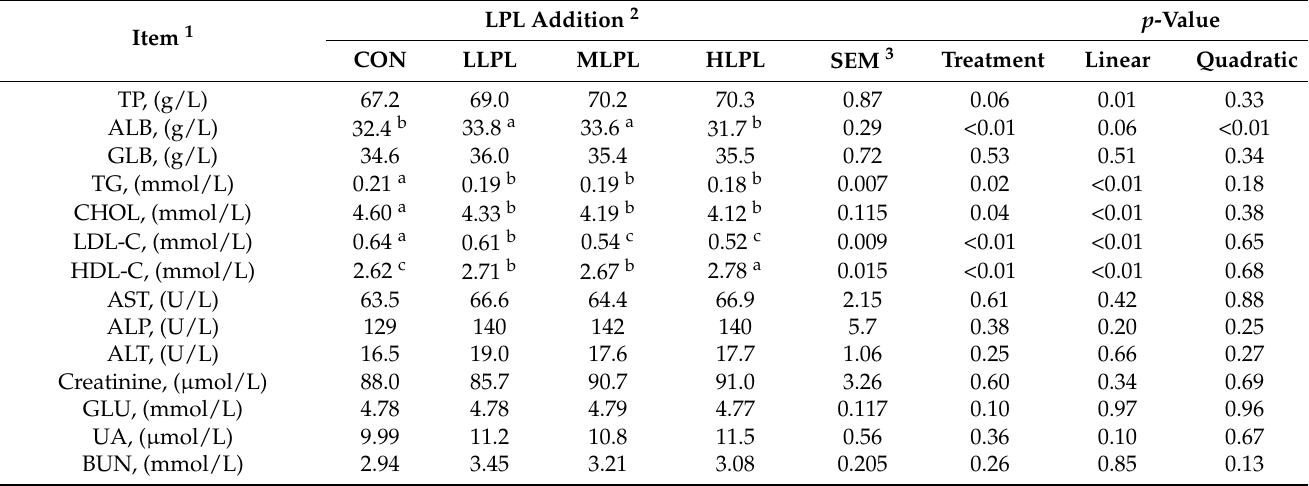
Table 4. Effect of dietary lysophospholipid supplementation on the blood metabolic parameters of beef cattle.